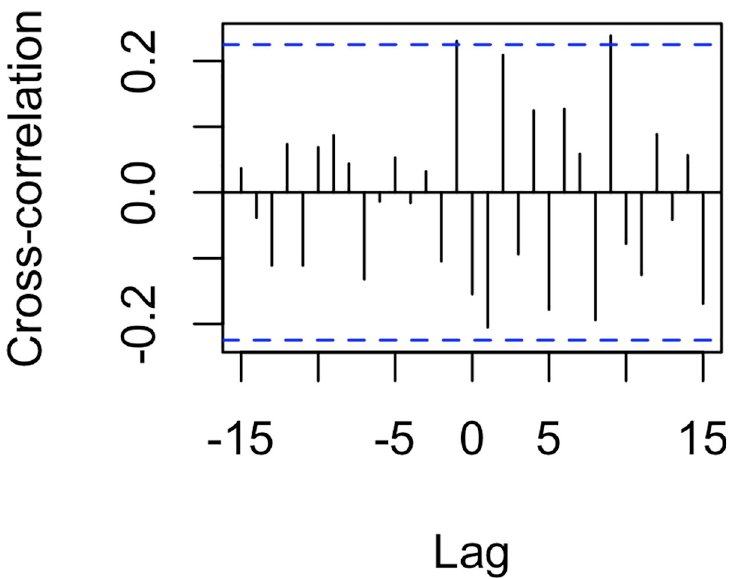
Fig 18. Cross-correlation plot for social cohesion and count of daily